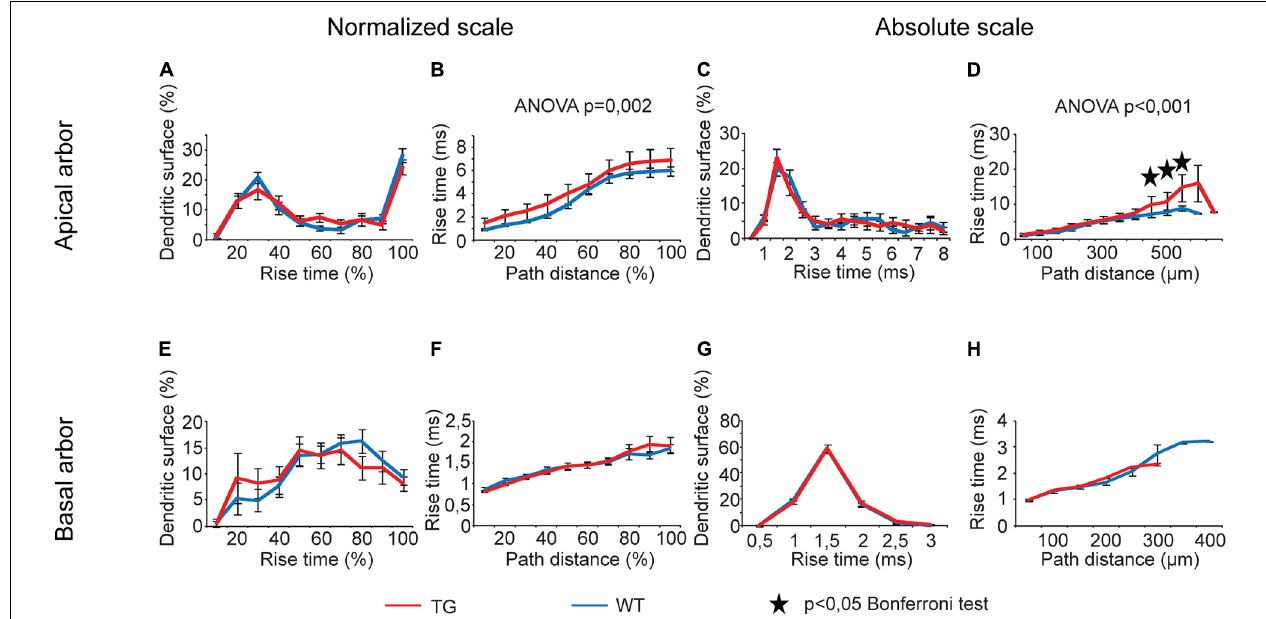
FIGURE 9 | Alterations in rise times of somatic EPSPs in advanced tauopathy. Dendritic PSPs were generated by local dendritic synaptic conductance changes at different distances from the soma, according to an alpha function with kinetic parameters corresponding to AMPAR-mediated single-synapse activities. For better visibility, distribution of dendritic surface area over absolute scale of rise times is shown up to rise times where at least 3–3 data points for WT (blue lines) and TG neurons (red lines) were present and statistical tests could be performed. Outside this range, percentages of dendritic surface areas converged to zero. Asterisks mark path distance regions where simulated PSPs, after traveling to the soma, led to statistically significant rise times of somatic EPSPs in WT and TG neurons (Bonferroni post hoc test, p < 0.05).